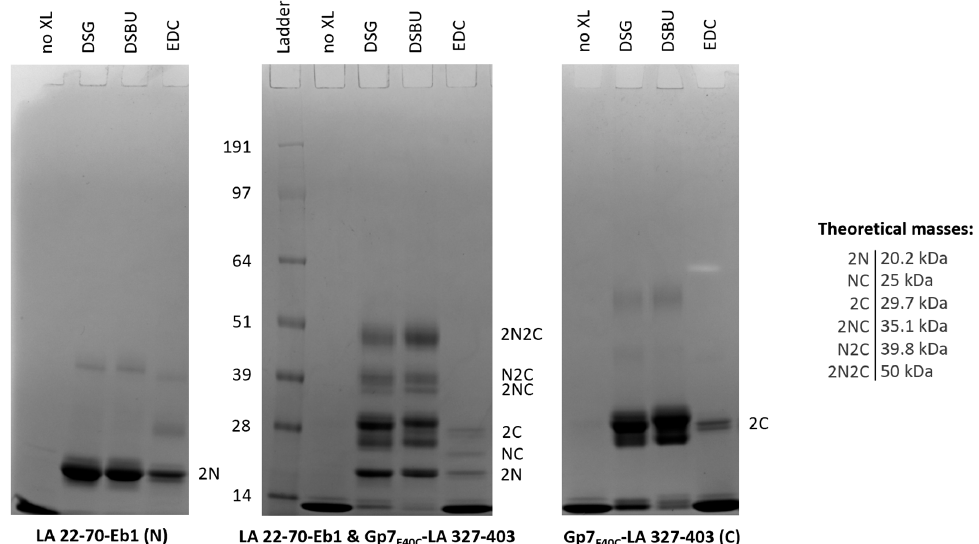
Figure 7. Reducing SDS-PAGE analysis of LA 22-70-Eb1, Gp7 F40C -LA 327-403 and the SEC-purified complex of these two fragments without cross-linking (no XL) and after cross-linking with DSG, DSBU and EDC. The most likely stoichiometry of different bands is given at the right-hand side of each gel, where letters N and C indicate the N- and C-terminal fragments respectively. Theoretical masses of all bands are given in the side panel.